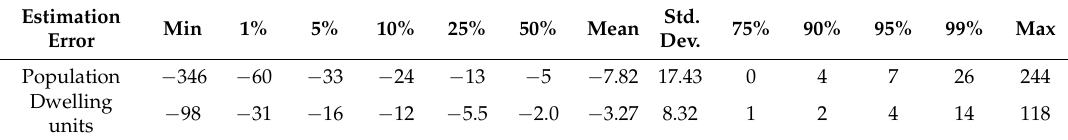
Figure 8. Histogram of the absolute error for population and dwelling units in the year 2011. The error is measured as the difference between estimated values and reference values. Table 2. Absolute error of the results at the study area level from calculating the difference between estimated values and reference